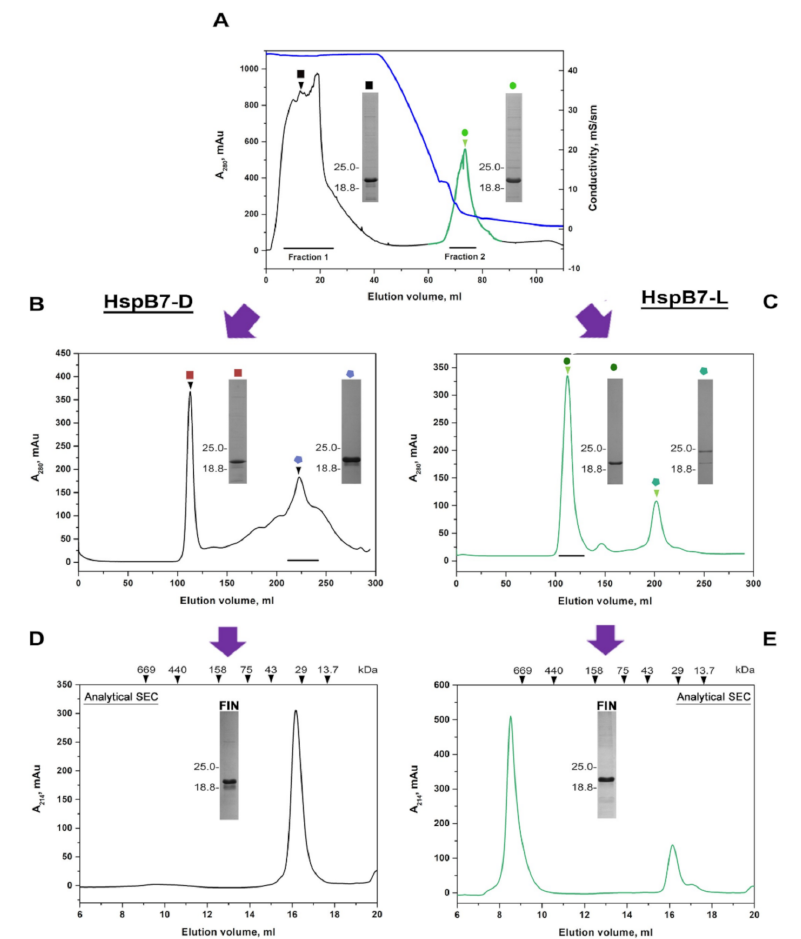
Figure 1. Chromatographic stages of recombinant HspB7 purification. ( A ) Hydrophobic chromatog- raphy of crude HspB7 preparation on HiTrap Phenyl column. Blue line represents conductivity. Fraction 1 and Fraction 2 were collected separately and subjected to SEC. ( B ) SEC of Fraction 1 loaded on preparative HiLoad Superdex 200. Fractions marked on the elution profile were collected, concen- trated, and their oligomeric state was analyzed by analytical SEC on Superdex 200 column (panel D ). ( C ) Proteins retarded on HiTrap Phenyl column (Fraction 2 in panel A ) were pooled and subjected to SEC on HiLoad Superdex 200 column. Fractions containing proteins with a high molecular weight (marked on elution profile) were collected, concentrated, and subjected to analytical SEC of Superdex 200 column (panel E ). Molecular weights (kDa) of protein standards are indicated at the top of panels ( D , E ), SDS-PAGE of fractions marked by colored squares and circles and final preparation (FIN) of HspB7 are presented on